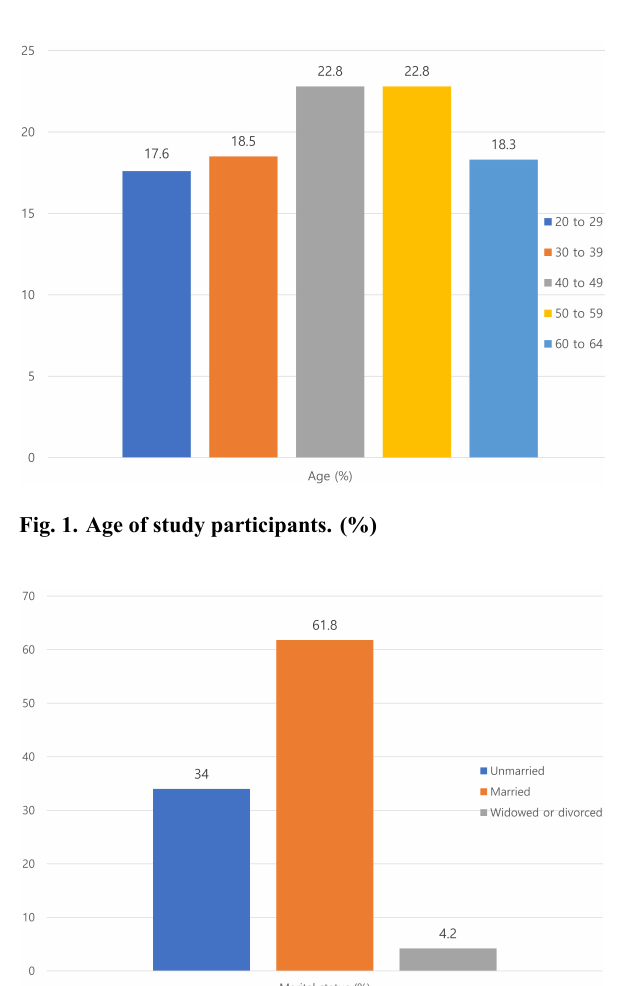
Fig. 4. Monthly average income of study participants.